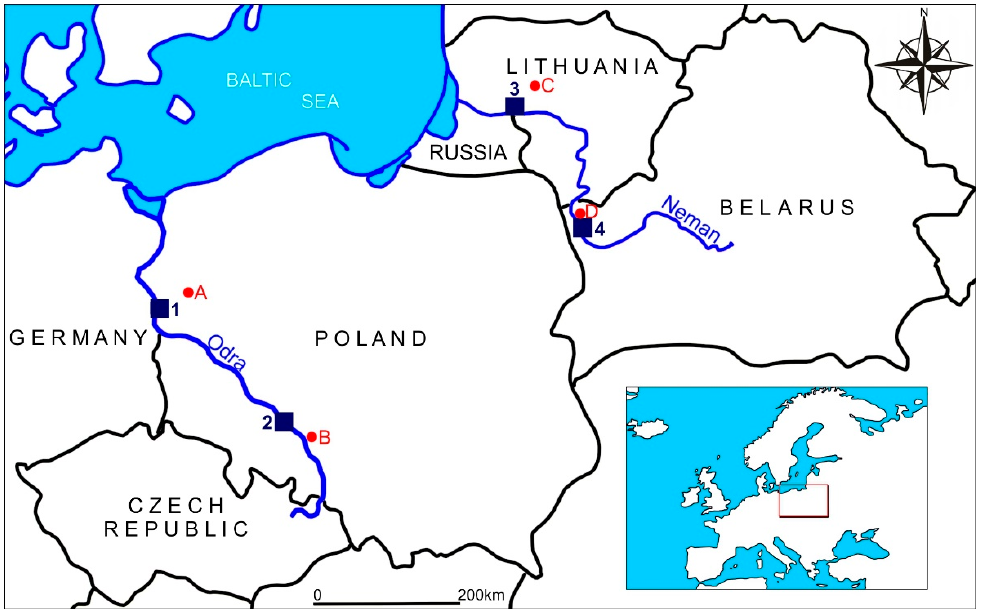
Figure 1. Location of the study objects: hydrological stations (1: Oder–S ł ubice, 2: Oder–Brzeg, 3: Nema–Smalininkai, 4: Neman–Grodno), meteorological stations ( A : Gorzow Wlkp, B : Opole, C : Raseiniai, D : Grodno).